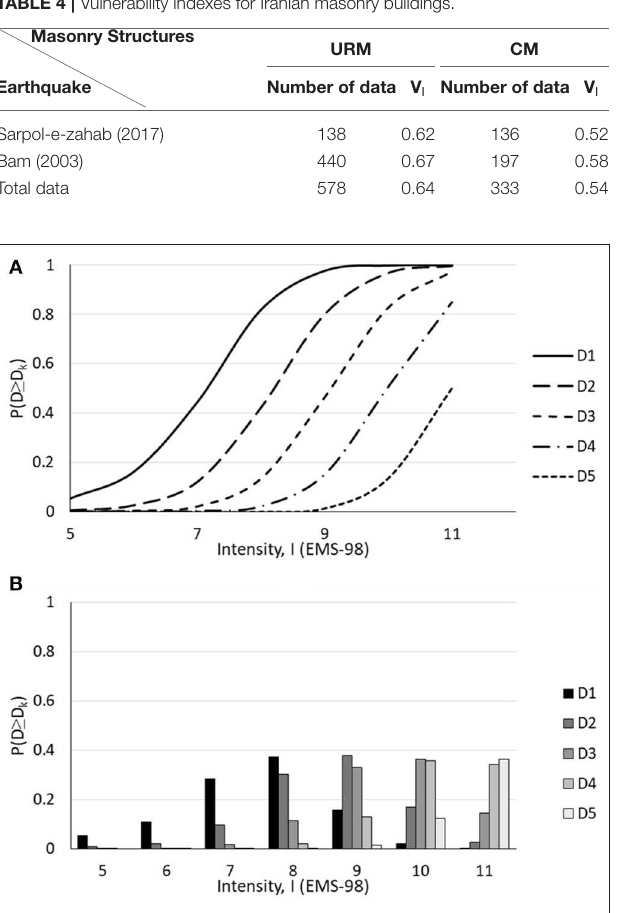
Frontiers in Built Environment |